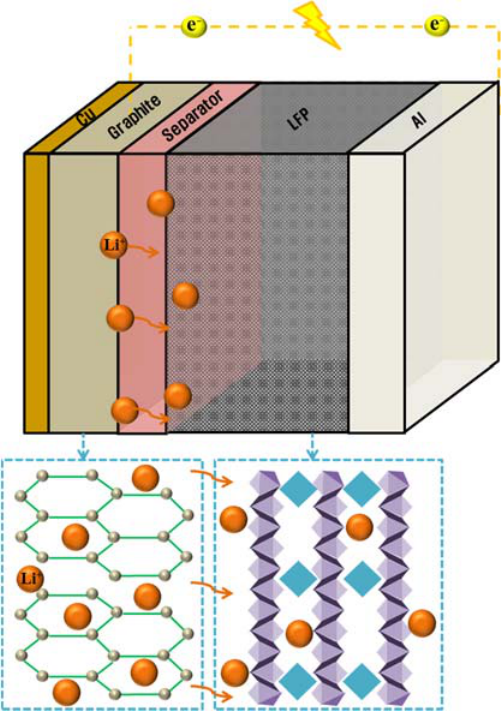
Figure 1. Schematic of a lithium ‐ ion battery with LiFePO 4 during discharging operation.